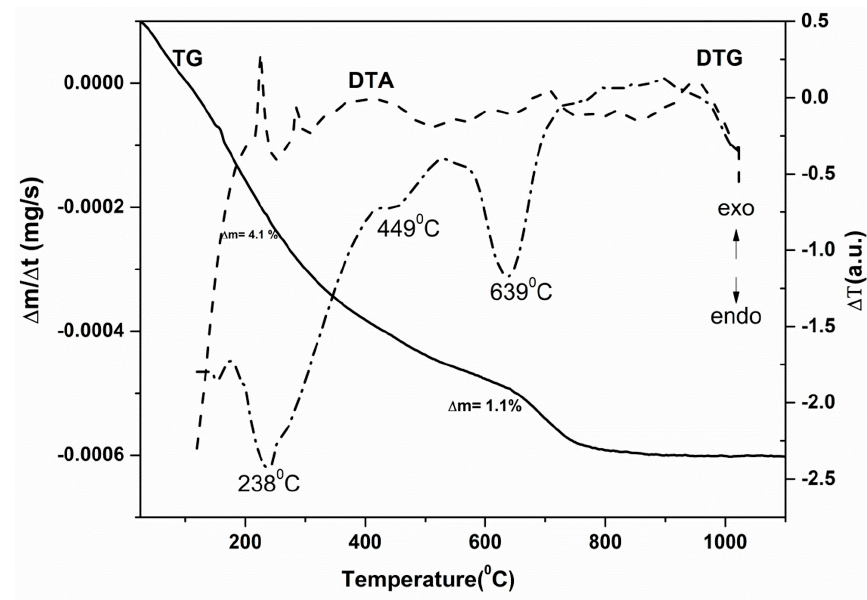
Figure 10. TG, DTA, and DTG curves of ZnO-Au1 nanocomposites.